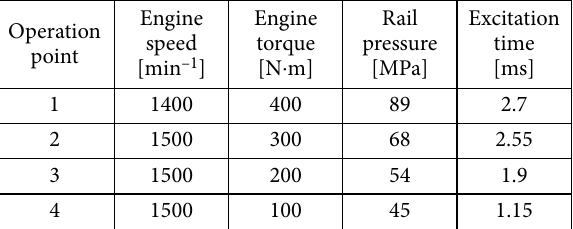
Table 2. Engine operating points for the injection rate measurements Operation point